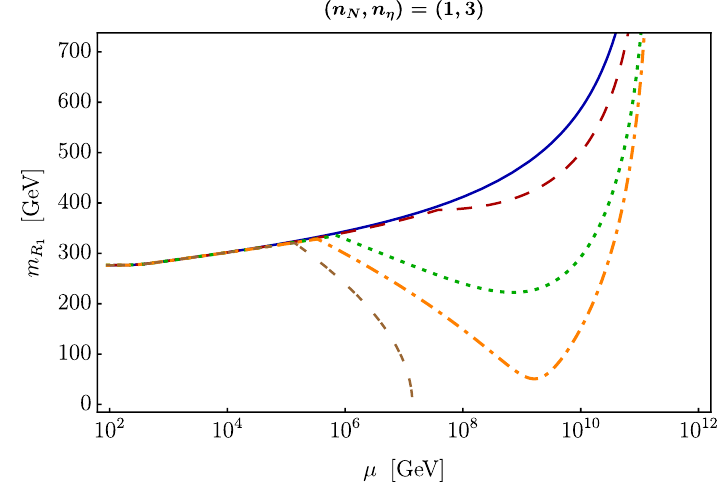
Figure 4 . Evolution of the lightest scalar mass m R Scotogenic model. The scalar parameters are set to (cid:21) aaaa (cid:0) (cid:1) and m 2 = 200 2 ; 300 2 ; 400 2 GeV 2 , while M N takes the values 1 TeV (blue), 1 : 5 TeV (red, dashed), (cid:17) 1 : 9 TeV (green, dotted), 2 : 025 TeV (orange, dash-dotted) and 2 : 2 TeV (brown, double